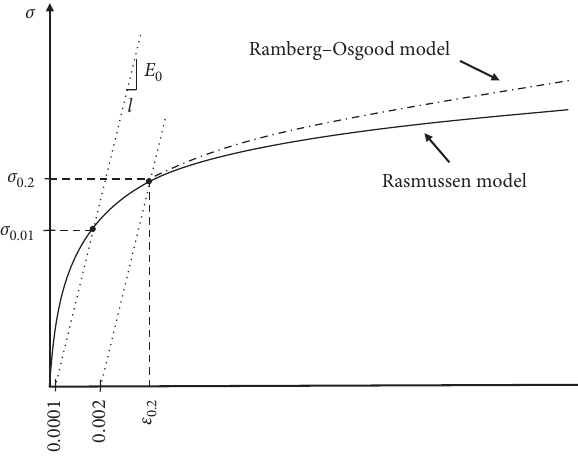
Figure 14: Rasmussen